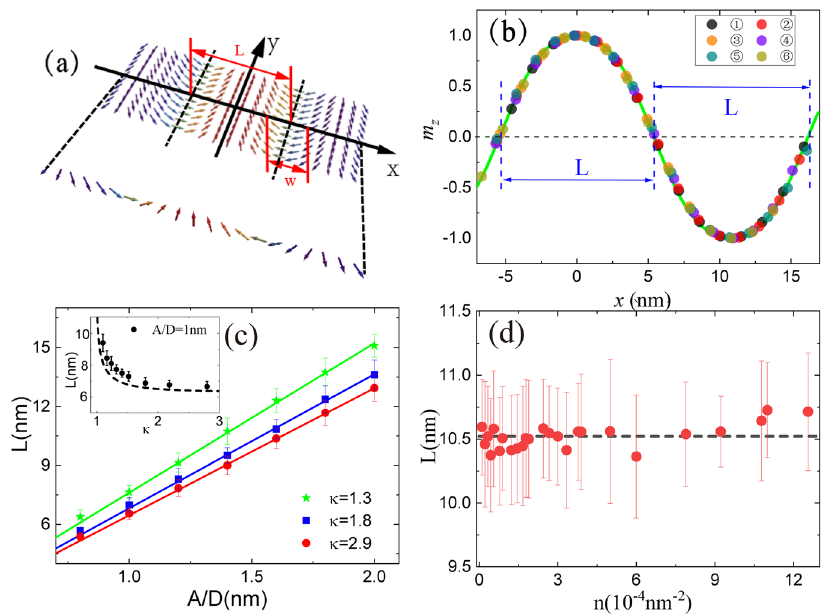
Fig. 2 Properties of stripe skyrmions. a Schematic diagram of spin texture of parallel stripes. b Symbols, from different stripes labelled by textcircledn in h i h i Fig. 1g – i, are m z ¼ cos Θ from MuMax3. The green solid line is the fi t of Θ ð x Þ ¼ 2arctan sinh ðj x j = w Þ . ( Θ ≤ π /2) and Θ ð x Þ ¼ 2arctan sinh ð L = 2 w Þ ( Θ ≥ π /2) sinh ð L = 2 w Þ sinh ððj x (cid:3) L jÞÞ = w Þ with L = 10.78 nm and w = 3.05 nm. x = 0 is the centres of white stripes. All data from different stripes fall onto the same curve means that stripes of the same width are basic building blocks of stripe skyrmions. c A / D -dependence of stripe width L for various κ = π 2 D 2 /(16 AK ) = 1.3 (the green stars); 1.8 (the blue squares); and 2.9 (the red circles). The solid lines are the fi ts of L = aA / D with a = 7.61 for κ = 1.3; a = 6.82 for κ = 1.8; a = 6.47 for κ = 2.9. Inset: the dependence of L on κ for A / D = 1 nm. A , D , and K are exchange stiffness constant, the Dzyaloshinskii – Moriya interaction coef fi cient, and easy-axis anisotropy, respectively. Symbols are the numerical data and the dashed line is the theoretical prediction without any fi tting parameter. The error bar is the standard deviation of stripe width from various places. d The dependences of stripe width L on skyrmion number density for A = 10 pJ m − 1 , D = 6 mJ m − 2 , K = 0.49 MJ m − 3 , and M = 0.58 MA m − 1 . M s s is saturation magnetization. The number of skyrmions varies from 1 to 113 in our sample of 300 nm × 300 nm × 0.4 nm under the periodical boundary conditions. The dashed line is L = 10.52 nm. The error bars are the standard deviation of stripe width from various